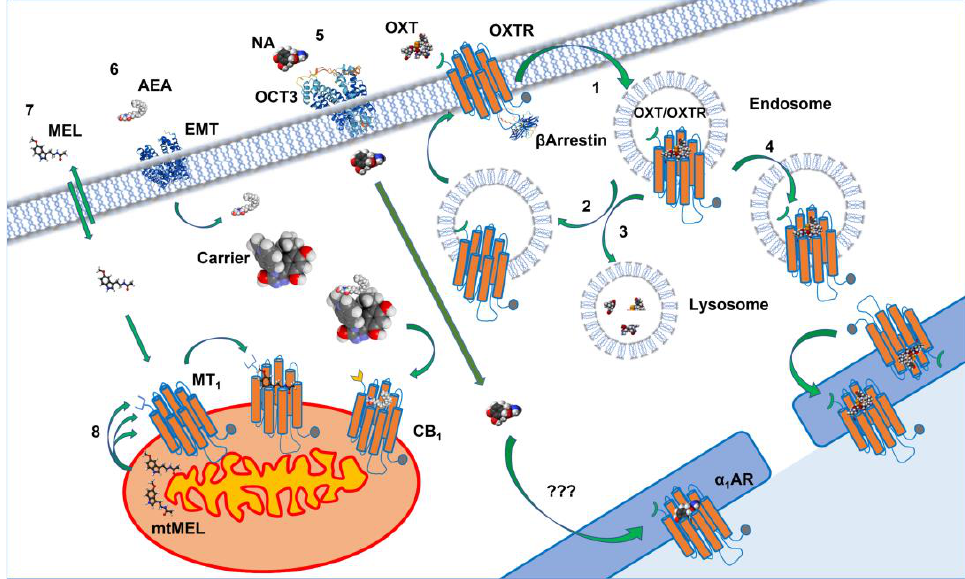
Figure 3. Extra- and intracellular GPCR activation by endogenous ligands. GPCRs are represented as orange proteins whose carboxyl groups are shown as gray dots whereas their N-terminal groups are differently shaped symbols of different colors. Canonically, ligands activate GPCRs at the plasma levels (“1”) where they promote internalization as shown for oxytocin receptors (OXTR). Internalized receptors are recycled (“2”) and their ligand degraded in lysosomes (“3”) or translocated in complex with their ligand to the outer and inner nuclear membrane (“4”). Some GPCRs embedded in the inner nuclear membrane are activated by hydrophilic ligands that cross the plasma membrane through transporters (organic cation transporter 3, OCT3) such as noradrenaline (NA) that activates the nuclear compartmentalized adrenergic receptors (“5”). Additionally, highly lipophilic ligands such as anandamide (AEA) cross the plasma membrane through transporters (EMT) and reach the cannabinoid receptors on the outer mitochondrial membrane through intracellular carriers, regulating cell respiration (“6”). Some ligands such as melatonin reach their intracellular GPCR targets by crossing the plasma membrane through simple diffusion and by an “automitocrine” mechanism in which the intracellular organelle itself synthesizes the ligand, autoregulating its own functions (“7”, “8”, respectively).